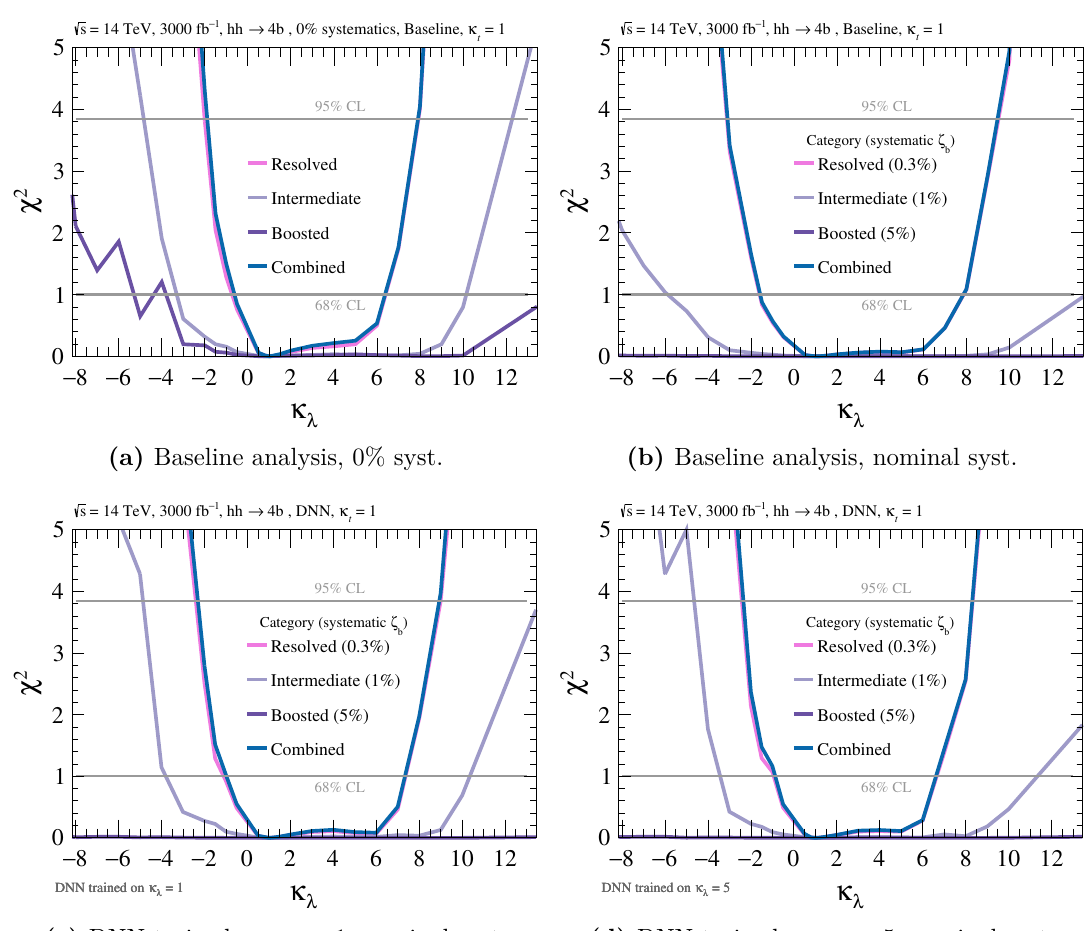
Figure 11. The χ 2 vs κ λ distributions with fixed κ t = 1 for different analyses and assumed systematics using L = 3000 fb − 1 . This is displayed in the resolved (pink), intermediate (lilac), boosted (purple) categories, together with their combination (blue). The baseline analysis is shown assuming (a) 0% background systematics and (b) the nominal systematics of 0.3%, 1% and 5% for the resolved, intermediate and boosted categories, respectively (table 6). The neural network analysis is shown with the nominal systematics for the DNN trained on (c) κ λ = 1 and (d) κ λ = 5 . The grey horizontal lines at χ 2 = 1 , 3 . 84 indicate the 68% CL, 95% CL thresholds respectively. The unphysical spikes for κ λ < 4 for the boosted χ 2 line in subfigure (a) and κ λ < − 5 for subfigure (d) are due to limited MC